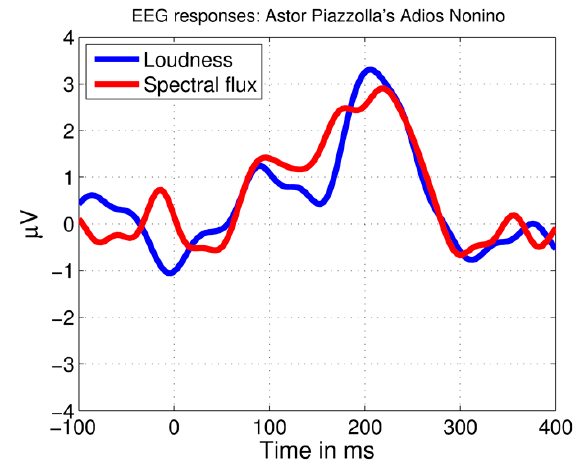
Figure 2. Brain responses to the tango piece measured with electroencephalography (EEG). Showing average brain responses to 10 loudness (RMS) and 10 spectral flux increases using the same method as applied in the current study. The time scale begins 100 ms before the feature increases (at − 100 ms) and the feature increases start at 0 ms.